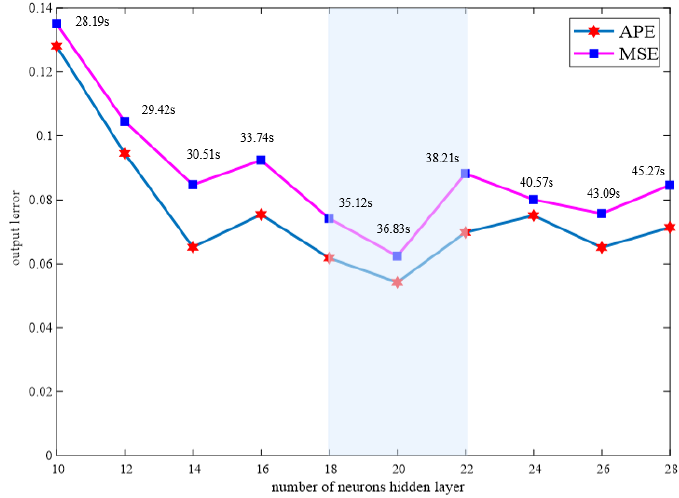
Figure 4. Relationship between the MOJS-ADBN model error and the number of hidden layer neurons.